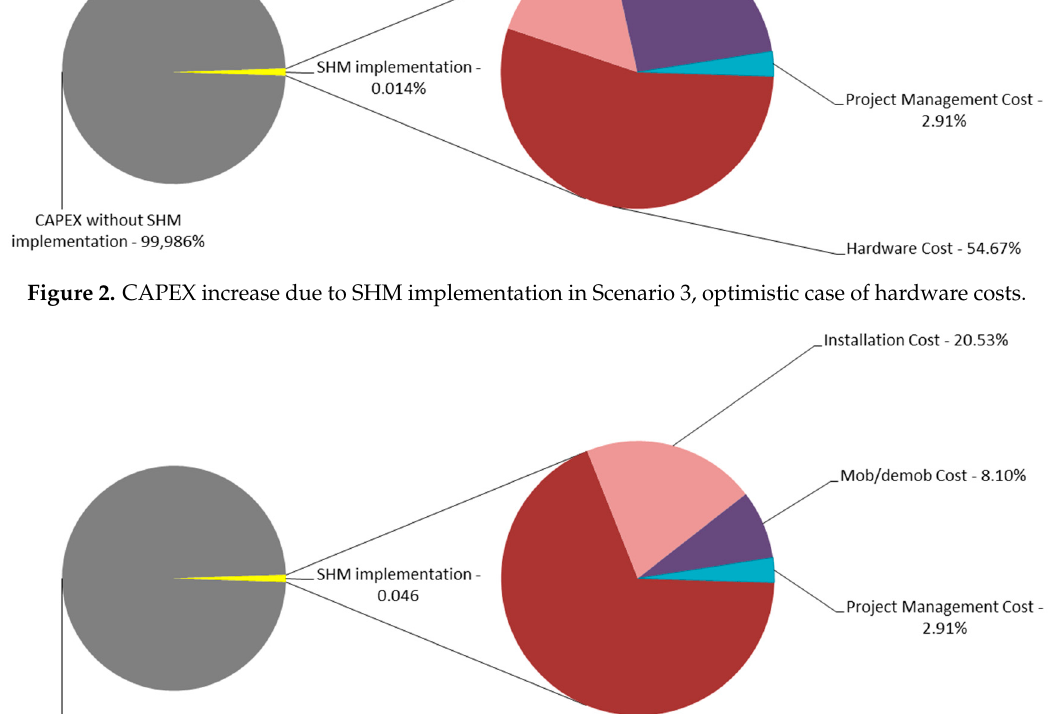
Figure 3. CAPEX increase due to SHM implementation in Scenario 3, average case of hardware costs.